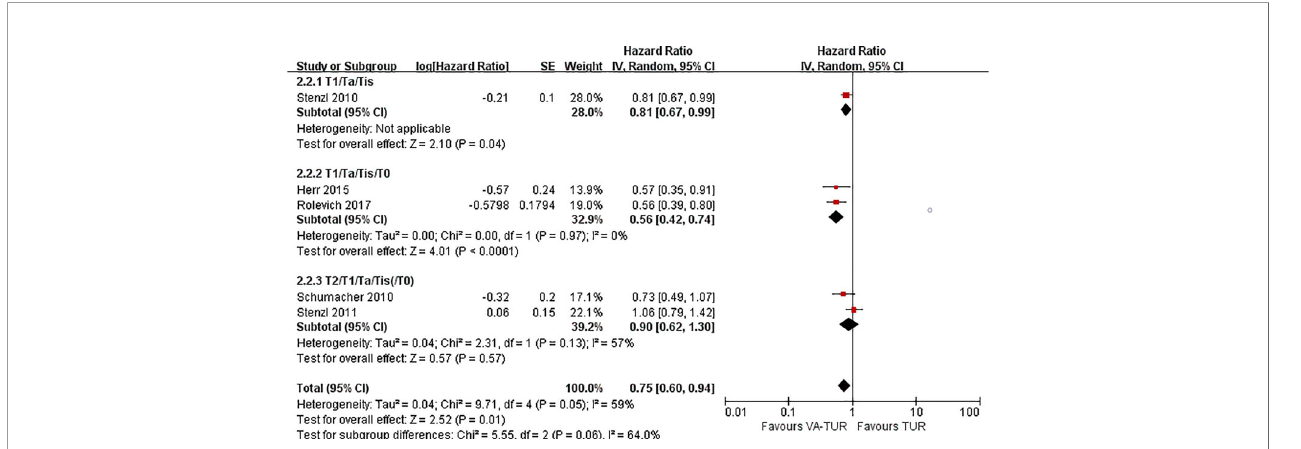
FIGURE 7 | Forest plot of PFS of VA-TUR versus TUR subgrouped by types of clinical stage of